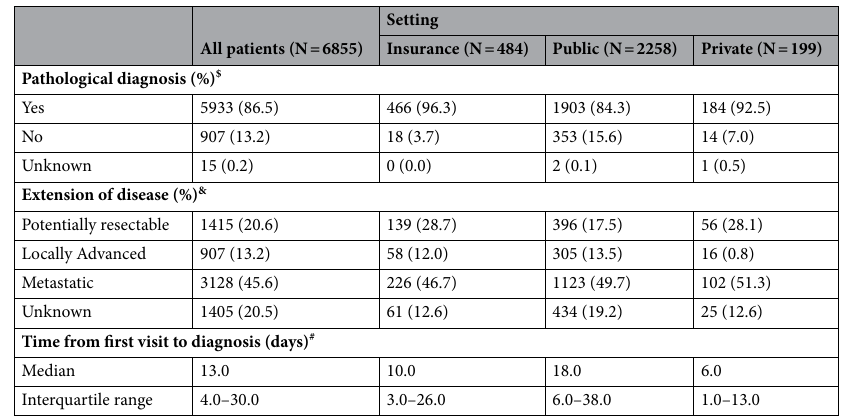
Table 2. Diagnostic characteristics according to the source of health care payment. $ p-value for the difference among Insurance, Public, and Private < 0.001 (Fisher exact test). & p-value for the difference among Insurance, Public, and Private < 0.001 (Fisher exact test). # p-value for the difference among Insurance, Public, and Private < 0.001 (Kruskal–Wallis test).